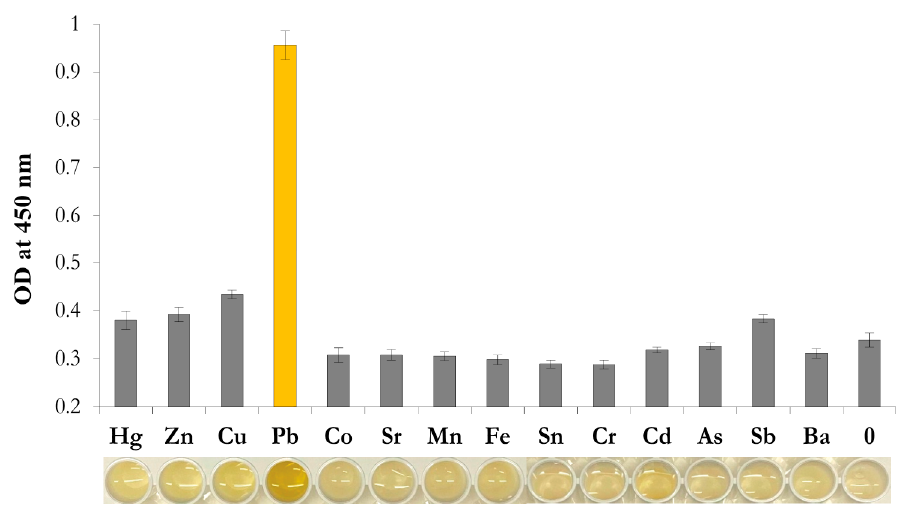
Figure 7. Selectivity of the TA-capped AuNPs toward various metal ions with a concentration of 100 ng·mL − 1 . ( N = 3). Insert: images of reaction media after testing the listed metal ions.